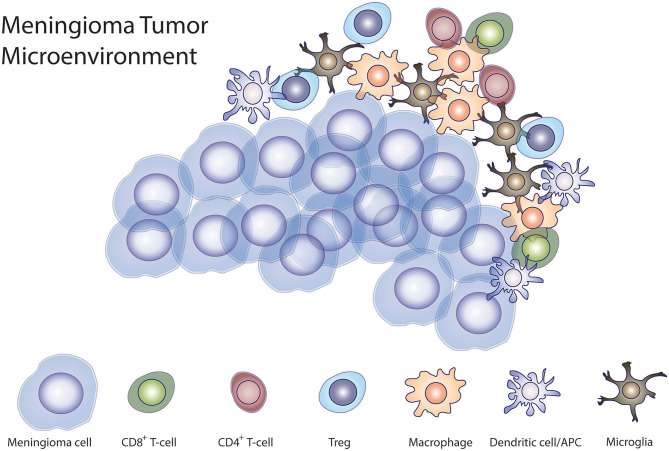
Meningioma immune microenvironment. Illustration demonstrating the interaction of tumor cells with different immune cells demonstrated to be present in the tumor microenvironment in meningiomas.